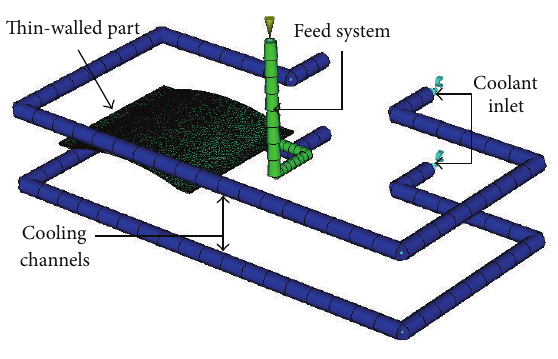
Figure 2: A mesh model for simulation